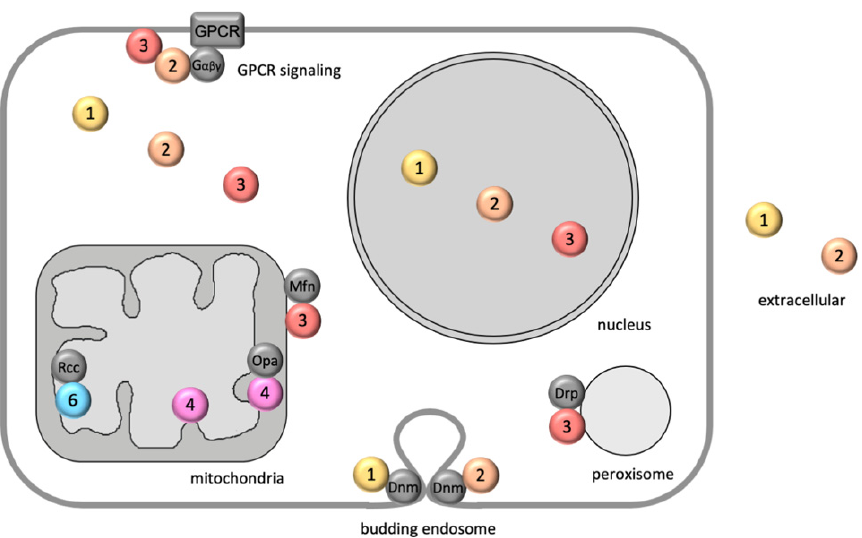
Figure 1. Localization and interaction partners of ubiquitously expressed NME family members in a schematic eukaryotic cell. NME proteins 1, 2, 3, 4 and 6 are shown as colored circles. Note that NME1-4 form hexamers, with cytosolic NME1-3 likely occurring mainly as heterohexamers [56]. Some of the known NME-interacting proteins are shown as dark grey circles. Members of the dynamin superfamily: Mfn, mitofusins 1 and 2 (Mfn1/2), Opa, optic atrophy protein 1 (Opa1), Drp, dynamin-related protein 1 (Drp1), Dnm, dynamin 2 (DNM2). Other proteins: GPCR, G-protein-coupled receptor; G αβγ , heterotrimeric G protein; Rcc, RCC1-like G exchanging factor-like protein (RCC1L or WBSCR16). For further details see text.